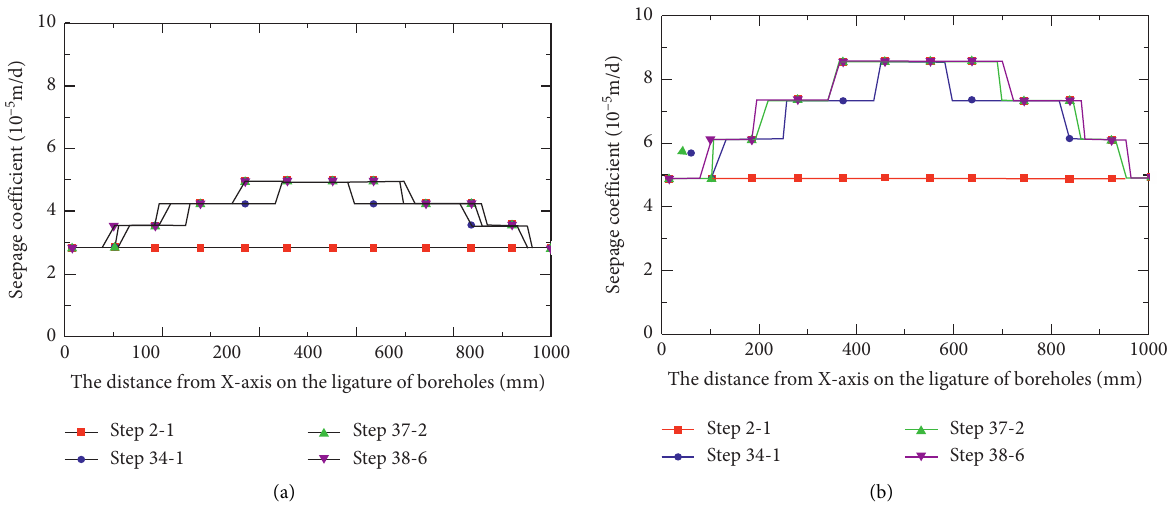
Figure 8: The seepage coefficient variation between boreholes during hydraulic fracturing. (a) Along the direction of borehole layout. (b) Perpendicular to the direction of borehole